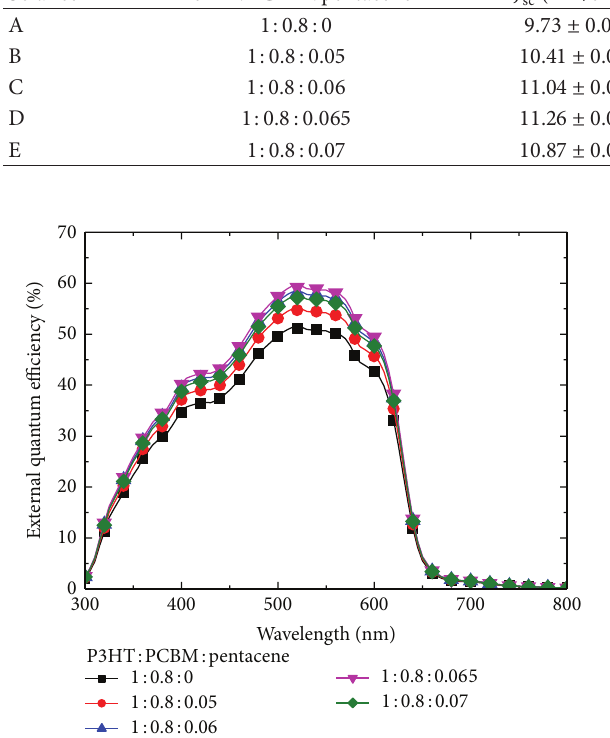
Table 2: The parameters of the inverted polymer solar cells with various pentacene doping contents. Solar cell